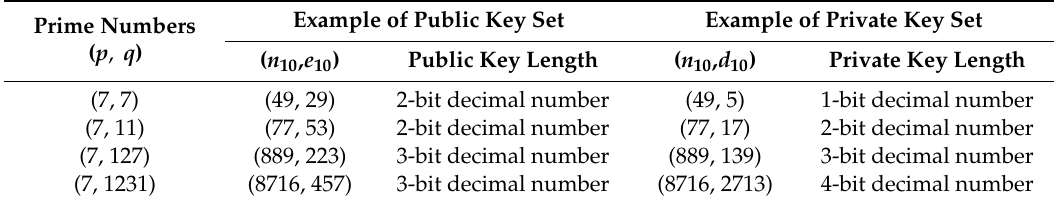
Table 2. Public and private RSA key sets generated by various q prime numbers.